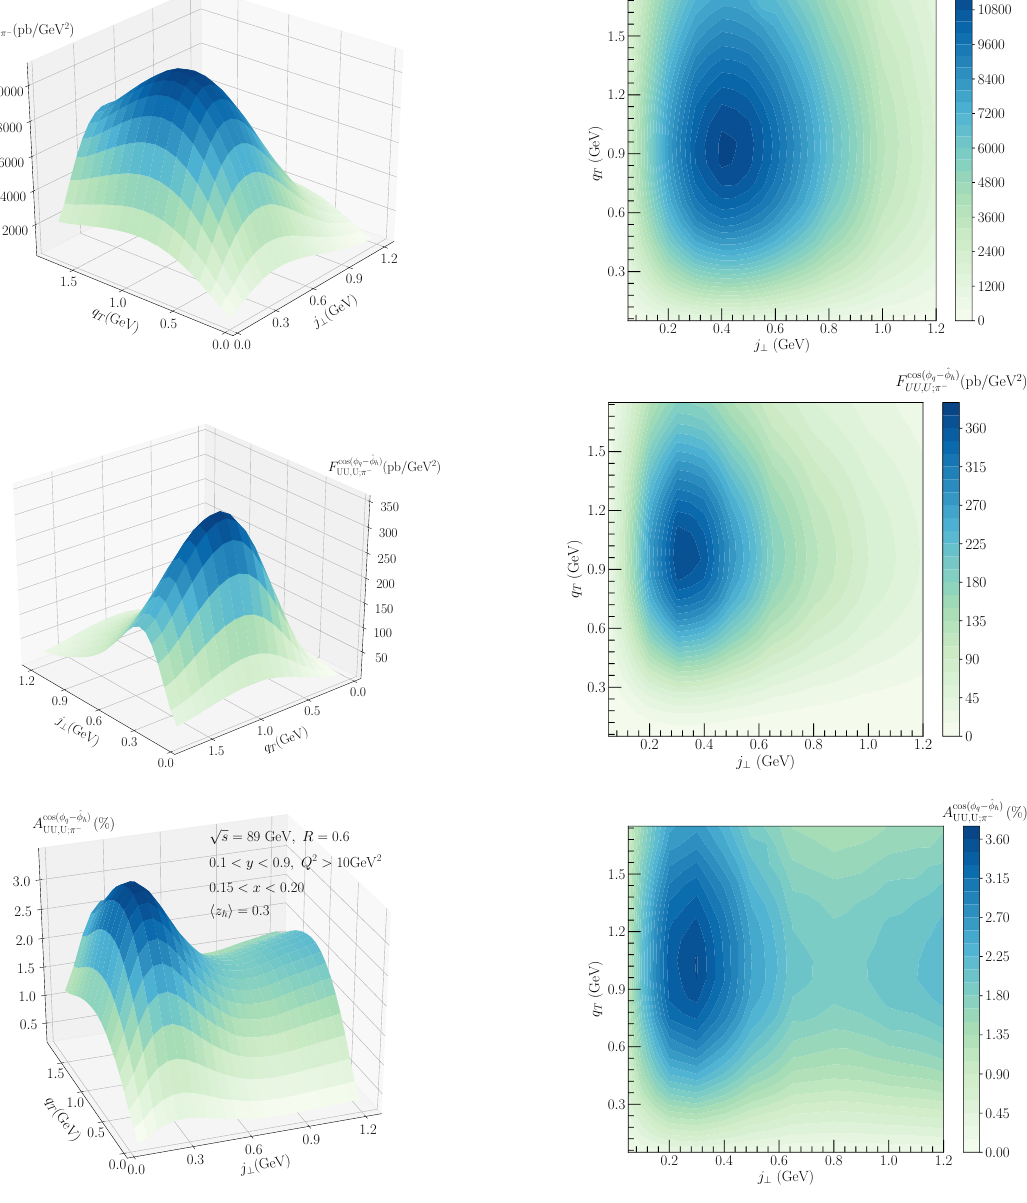
ˆ φ ˆ φ h ) h ) Figure 7 . F UU,U (first row), F cos( φ q − (second row) and A cos( φ q − (third row) as a function of UU,U UU,U jet imbalance q T and j ⊥ for unpolarized π − in jet production with electron in unpolarized ep collision √ with EIC kinematics, where we have applied s = 89 GeV, jet radius R = 0 . 6 , inelasticity y in range [0 . 1 , 0 . 9] , Q 2 > 10 GeV 2 , Bjorken- x in [0 . 15 , 0 . 20] and average momentum fraction h z h i = 0 . 3 . Left column: three dimensional plots of the structure functions and their ratio in q T and j ⊥ . Right column: contour plots of the structure functions and their